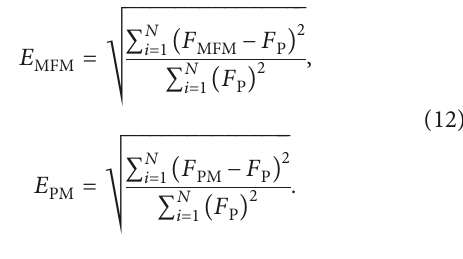
0.02m, f 1Hz, the piston speed-damping force (cid:31) (cid:31)